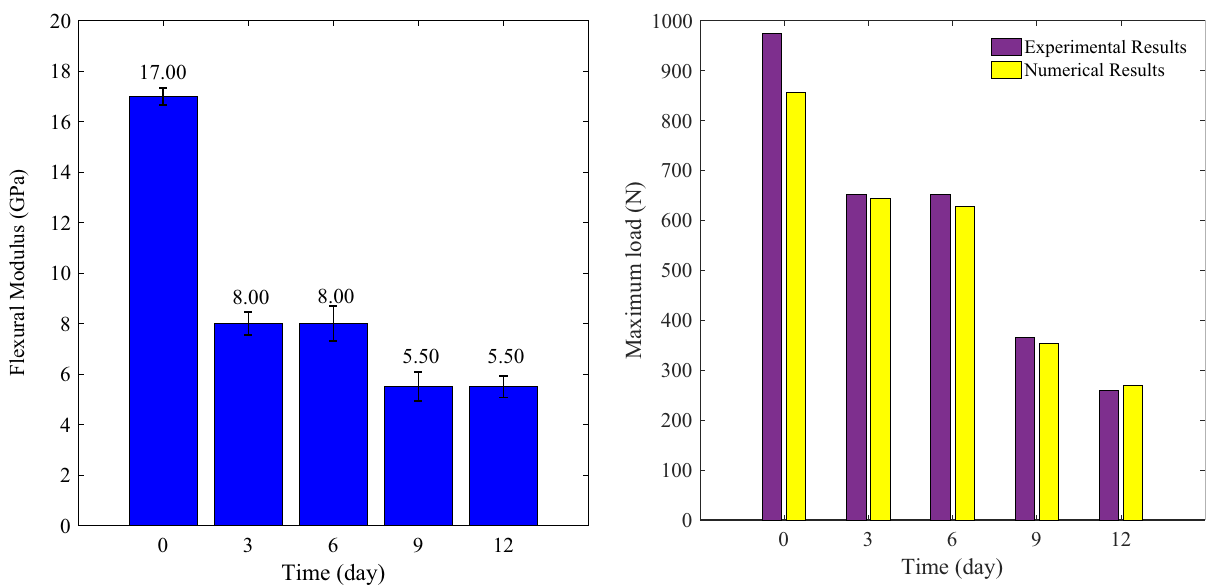
Figure 17: Comparison of the maximum experimental and predicted loads for samples exposed to an acidic environment at